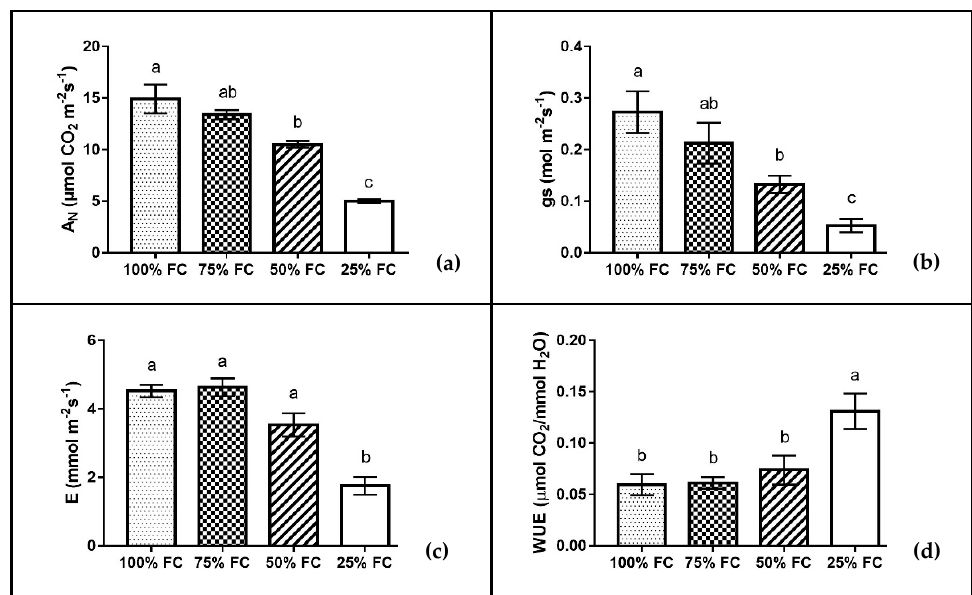
Figure 3. Net photosynthesis (A N ) ( a ), leaf conductance (gs) ( b ), transpiration rate (E) ( c ), and water use efficiency (WUE) ( d ) in zinnia. Plants were irrigated at field capacity (100% FC) or subjected to drought stress (75% FC, 50% FC, and 25% FC). Mean values ± standard error (S.E) (n = 6). Different letters indicate significant differences among the treatments as determined by Tukey’s test.